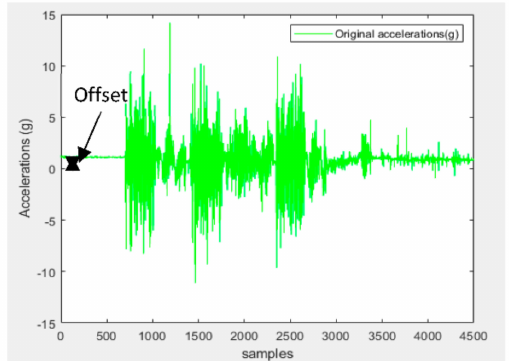
Figure 3. Calculation of Preliminary offset error and Vibration rectification error.